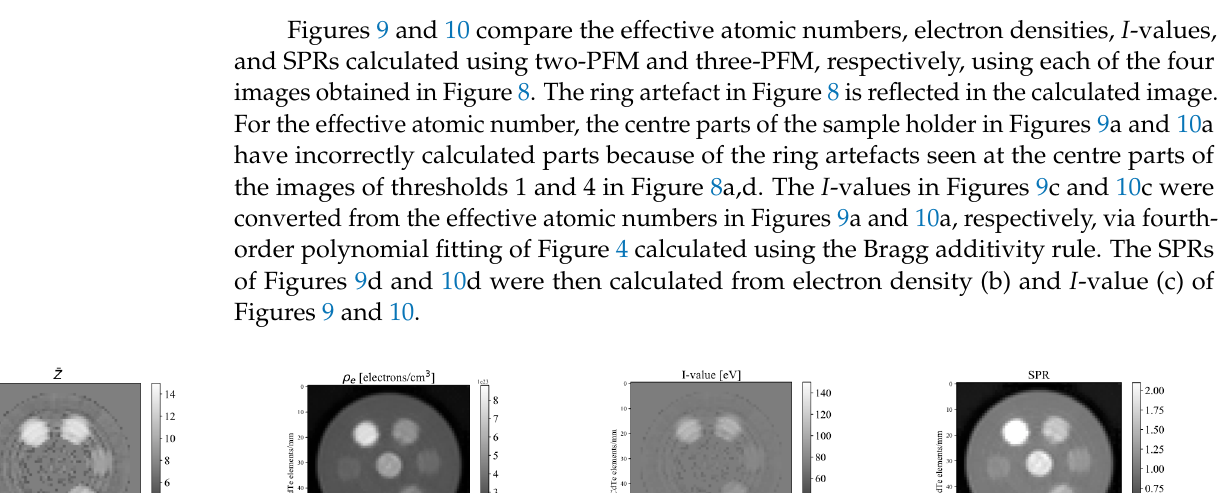
Figure 8. Reconstructed CT images, in which linear attenuation coefficient is corrected via the method in Figure 7, for ( a ) threshold one, ( b ) threshold, ( c ) threshold three, and ( d ) threshold four. The number above the rod in each figure corresponds to Figure 5c: 1. BE-H-10; 2. BE-N-10; 3. BE-T-10; 4. Aluminium; 5. poly(methyl methacrylate) (PMMA); 6. WD-3010; and 7. Graphite.